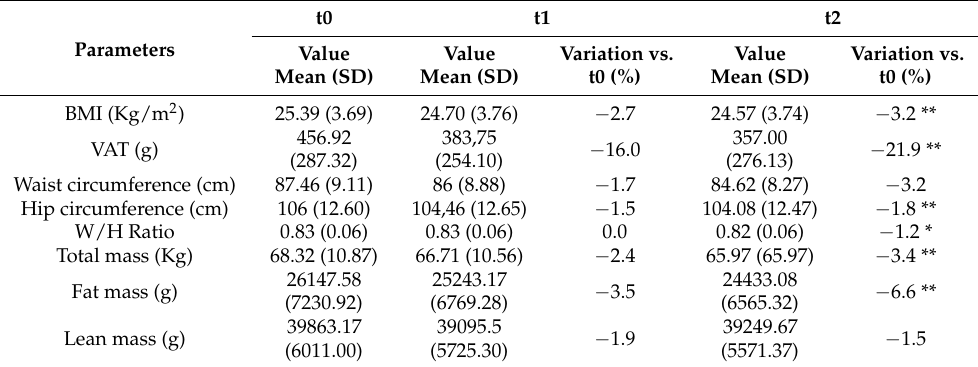
Table 4. Descriptive statistics for the body composition measured at baseline (t0) and after 60 days (t2) of BBR-PP supplementation.